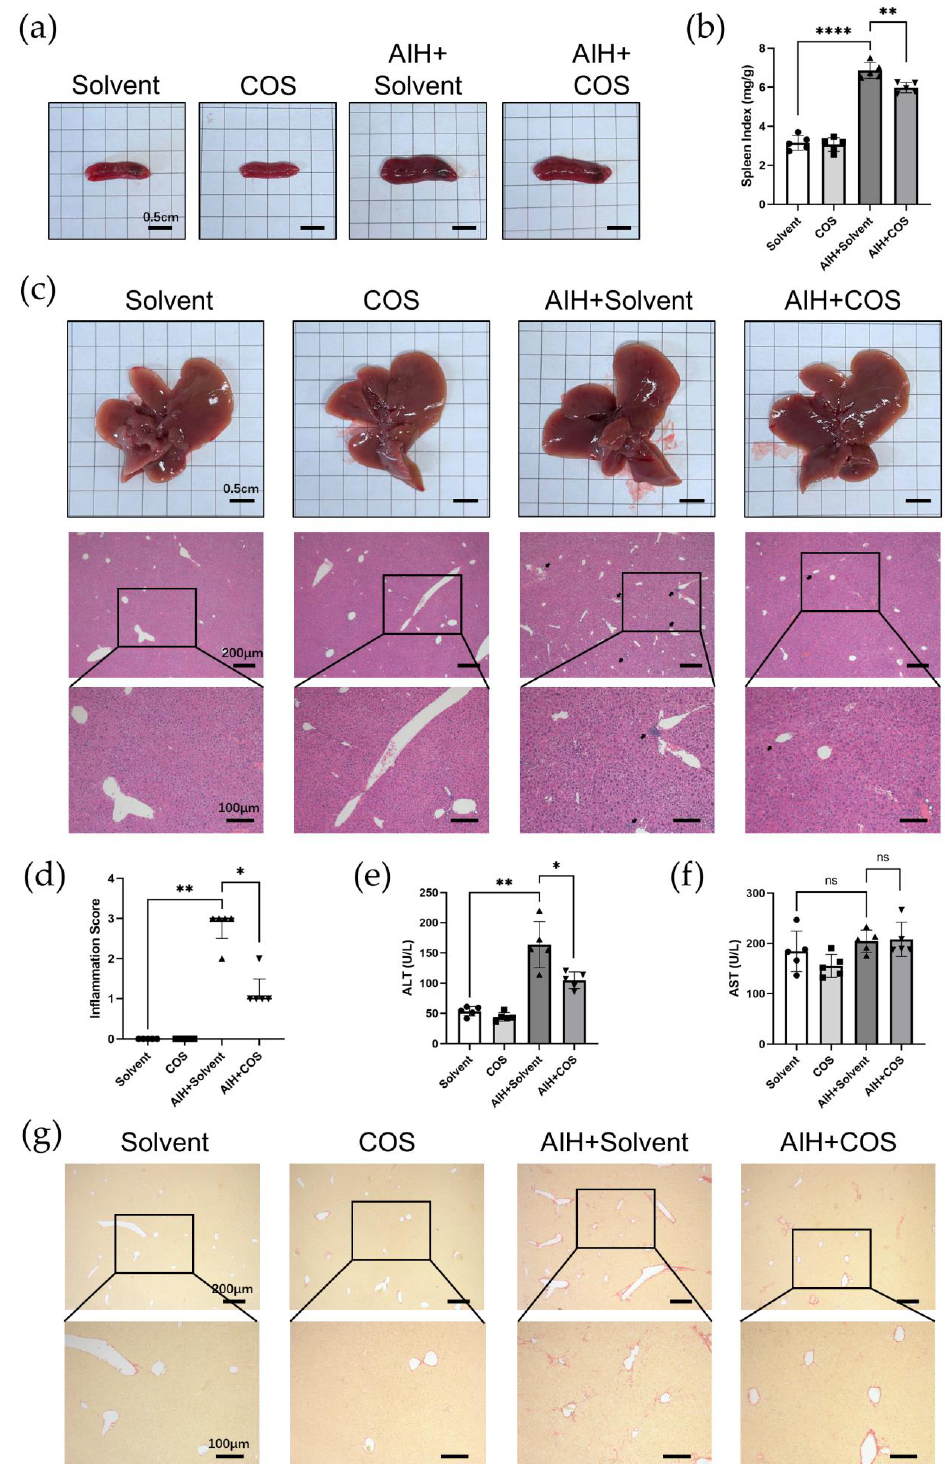
Figure 8. Costunolide ameliorated chronic murine autoimmune hepatitis. ( a ) Spleen gross appearance. ( b ) Spleen index (mg/g). ( c ) Representative liver gross appearance and H&E staining of liver sections (black arrows indicate immune cell infiltration). ( d ) Inflammation score of H&E staining of liver sections. ( e ) Effect of costunolide on serum ALT levels. ( f ) Effect of costunolide on serum ALT levels. ( g ) Representative Sirius-red staining of liver sections (Red color indicates collagen deposition). Data shown in ( b , d , e ) are from 5 individual mice per group. * p < 0.05, ** p < 0.01, **** p <